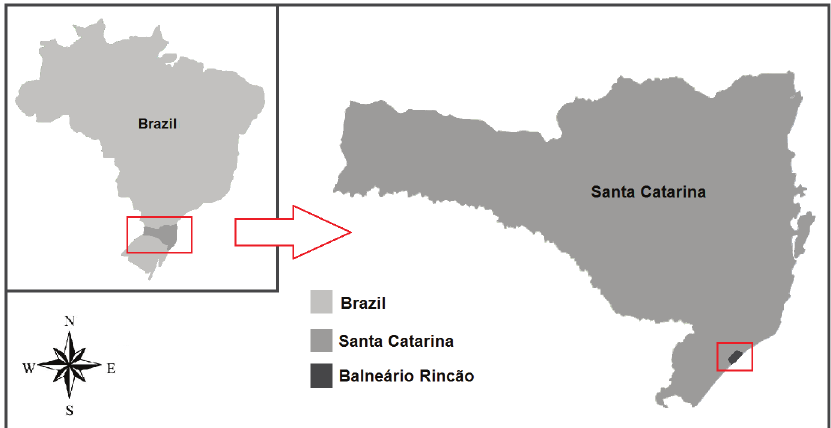
Figure 1 - Location of the city of Balneário Rincão. Font: Adapted Google